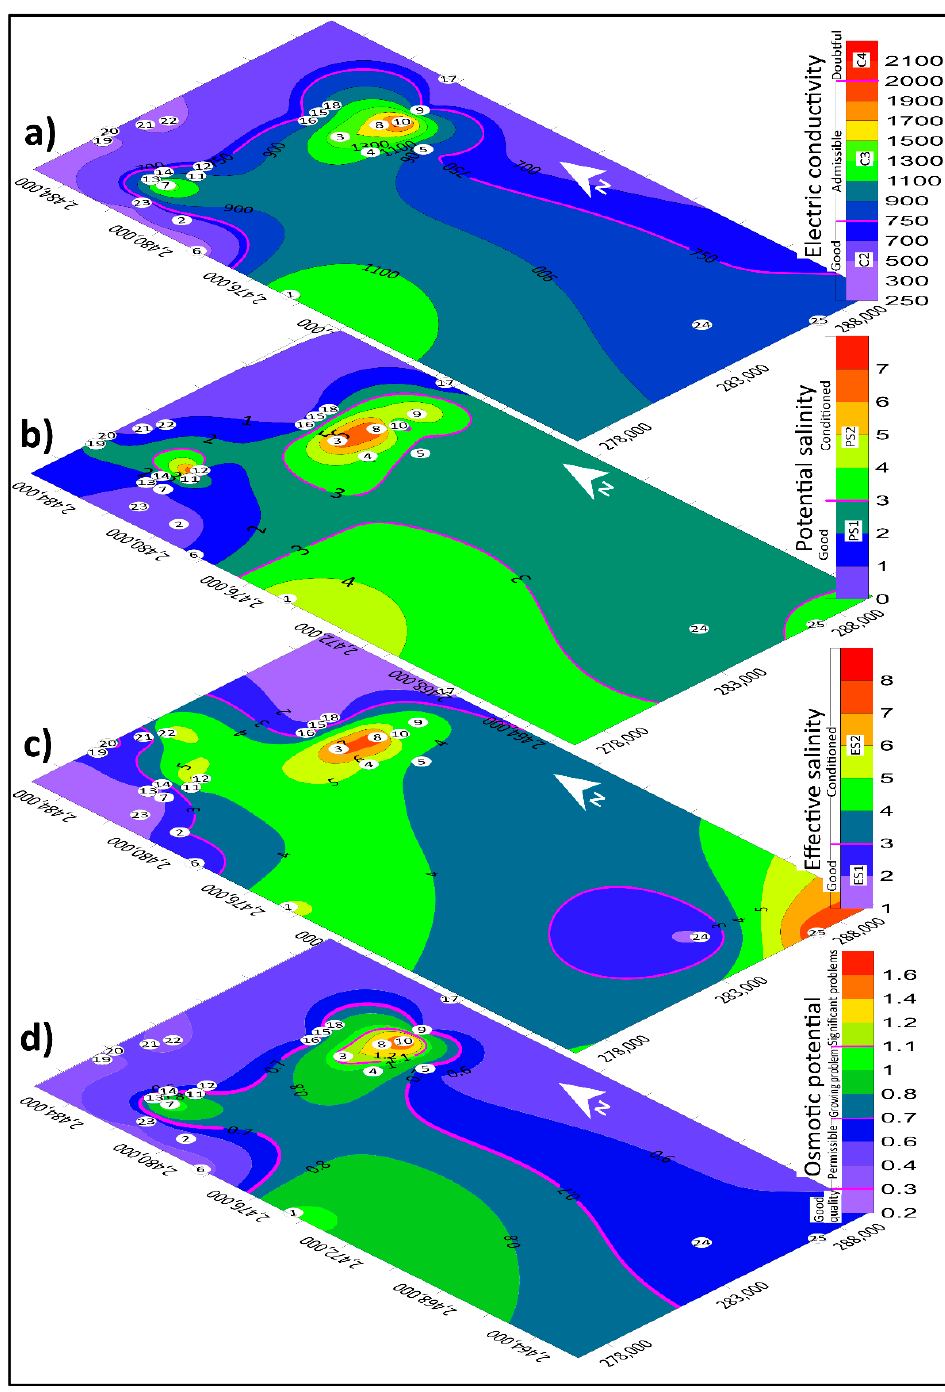
Figure 7. Spatial distribution of the indices: ( a ) EC, ( b ) PS, ( c ) ES, and ( d ) OP.